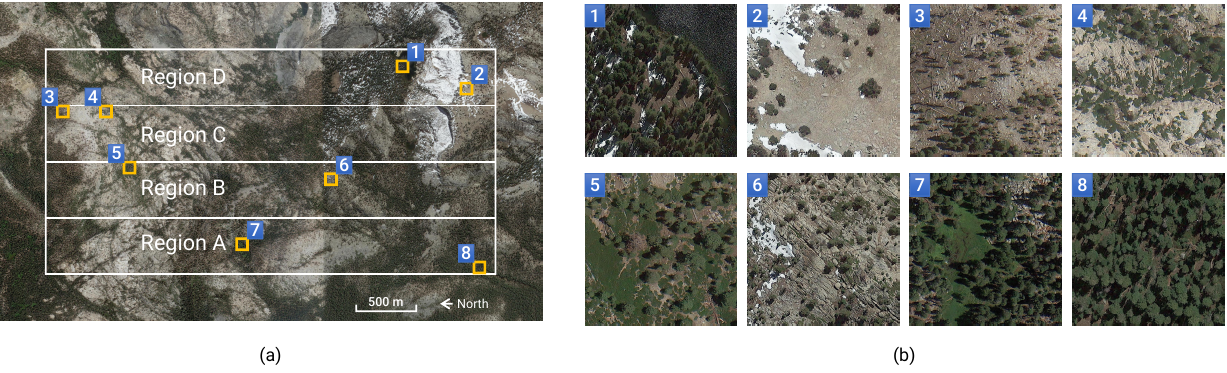
Figure 6. ( a ) The study area of the Yosemite Tree Dataset. ( b ) Example images cropped from different locations of the dataset.